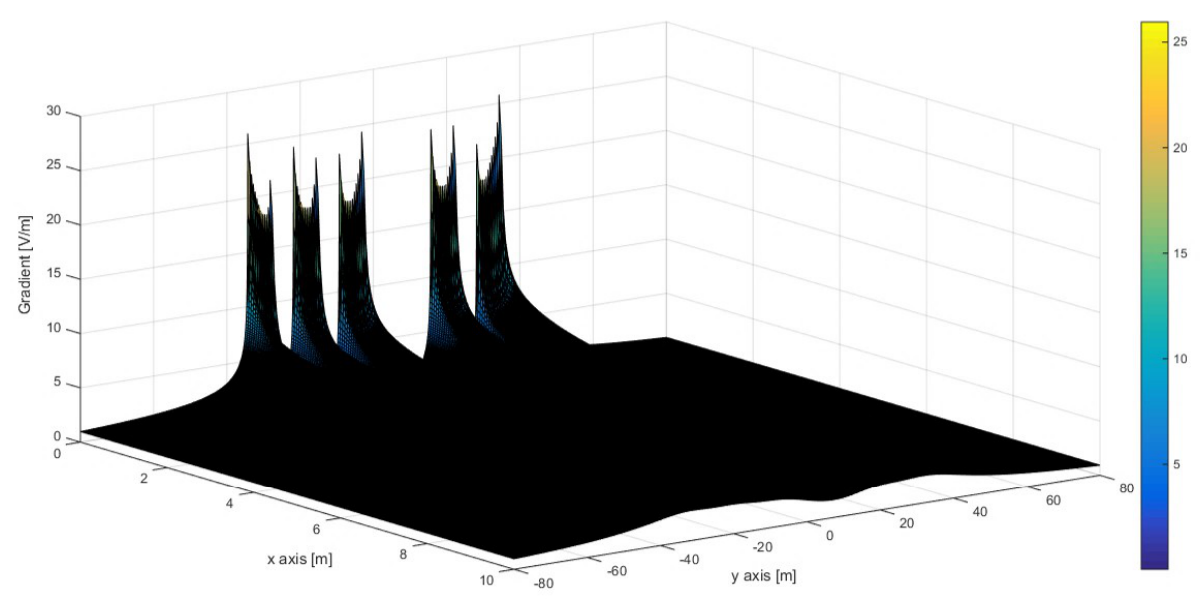
Figure 25. Electric field strength for method “C”, of linear current source, for an electrode station of 6 linear frames in a row with d frames = 6.50 m; each frame consists of 13 electrodes of active length L = 2.13 m, D el = 0.50 m, ρ w = 0.25 Ω · m, θ = 248 ◦ (area of Korakia), J full_load_steady = 22 A/m 2 (steady state and operation of 5 frames, except no. 4).